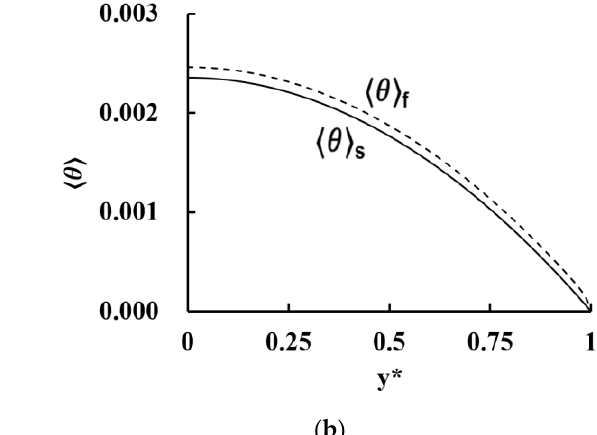
persion ratio are 𝑁𝑢 𝑉𝐻 = 5993 and 𝜖 ∗ 𝑘 𝑑𝑖𝑠𝑝 /𝑘 𝑓 = 5.35 while the same values are 135,610